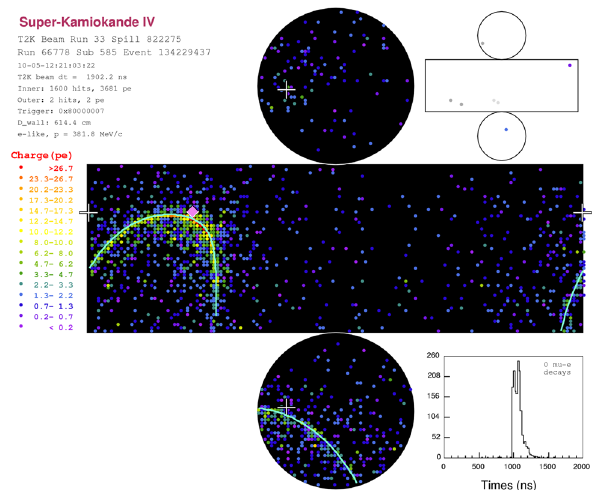
Fig. 55 The event display of an electron neutrino candidate